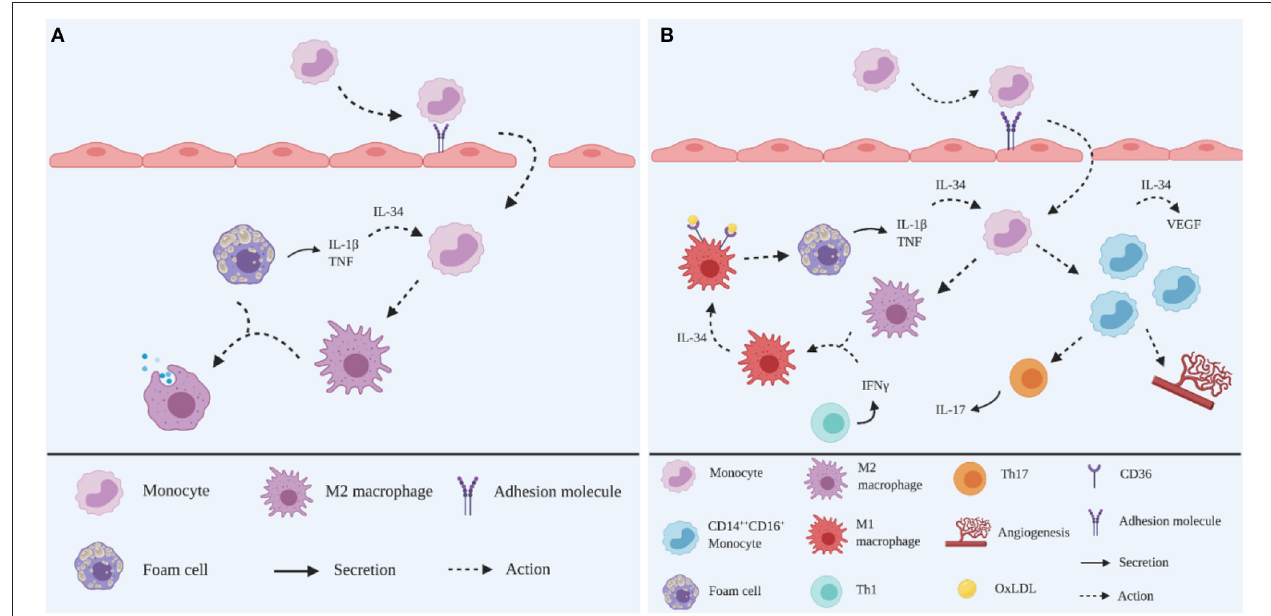
FIGURE 2 | Schematic representation of the roles of IL-34 in atherogenesis. (A) In the early stage, TNF and IL-1 β produced in the plaque microenvironment stimulate IL-34 production. Infiltrated monocytes are induced by IL-34 to differentiate into M2 macrophages to dampen the inflammatory responses by digesting OxLDL. (B) In the advanced stage, IFN γ produced from overwhelming inflammation skews M2 macrophages into an M1 phenotype. These M1 macrophages are induced by IL-34 to upregulate scavenger receptor CD36 to ingest OxLDL, leading to foam cell formation. IL-34 induces the expansion of CD14 bright CD16 + monocytes subpopulations, increasing Th17 polarisation and angiogenesis, together with increased VEGF production. Created with